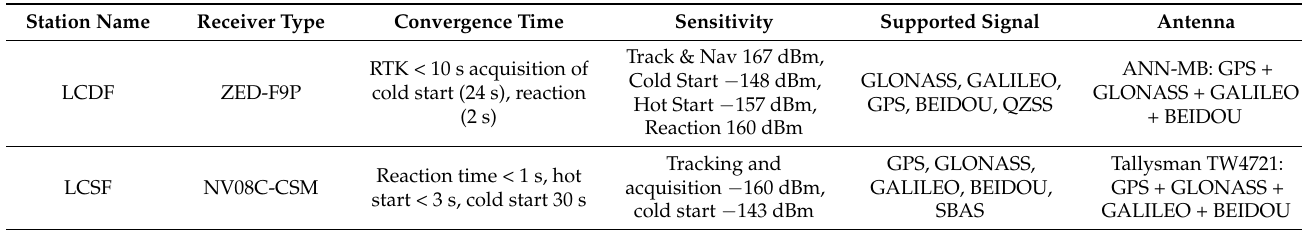
Table 1. Characteristics of the low-cost receivers.